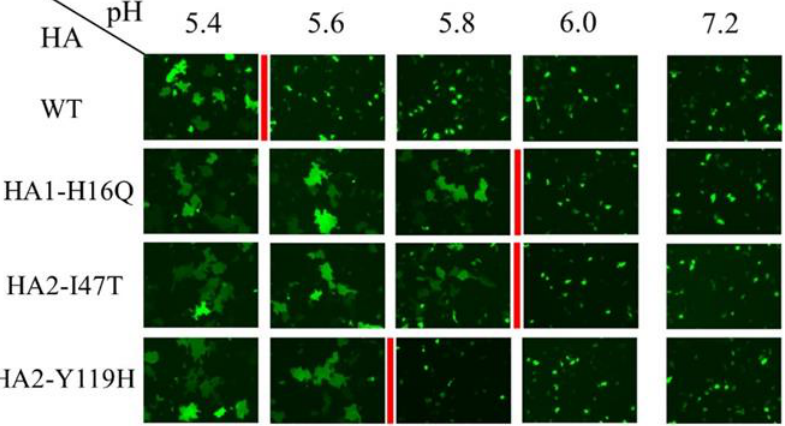
Figure 5. pH threshold for syncytium formation with HA mutations in A549 cells. The cells were co-transfected with the plasmids expressing mutant HAs (HA1-H16Q, HA2-I47T, or HA2-Y119H) or WT HA and a Venus-expression plasmid. Syncytium formation was induced with an adjusted pH buffer of pH 5.4 to pH 6.0 and with pH 7.2 as the control. The red line marks the border of pH for syncytium formation. The experiments were repeated thrice independently and the same results were obtained.